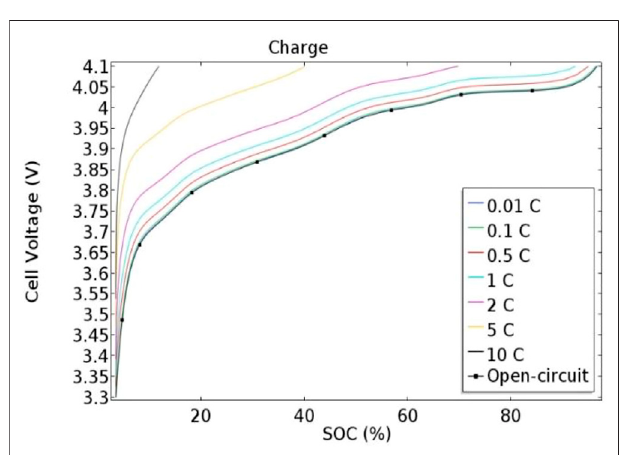
FIGURE 11 | State of charge (SOC) characteristics at various